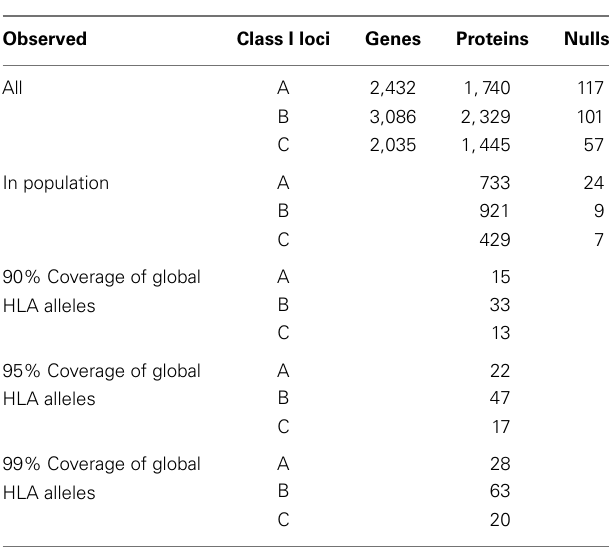
Table 1 |The count of HLA genes, proteins, null alleles, and their prevalence in theWorld’s population